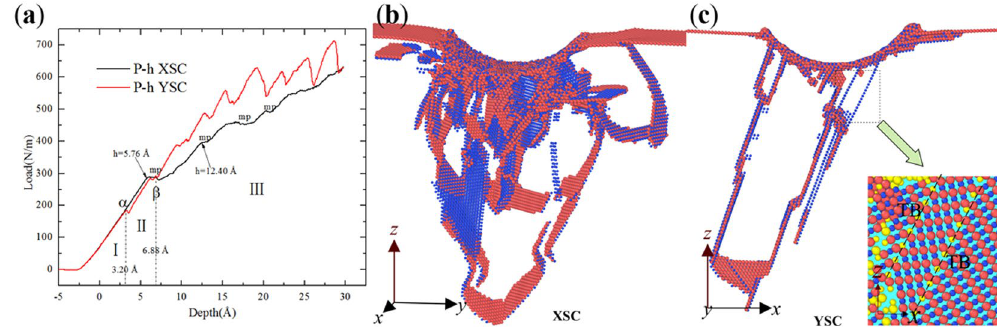
Figure 3. In-plane anisotropy of single crystal VN(111) with cylindrical indenter along different directions. ( a ) P - h curves of XSC and YSC; ( b ) and ( c ) microstructures in XSC and YSC at h = 25 Å, colored with atomic type. The inset is twin structure on x-z plane, colored with CSP . Atoms with CSP < 0.5 and indenter atoms have been removed.